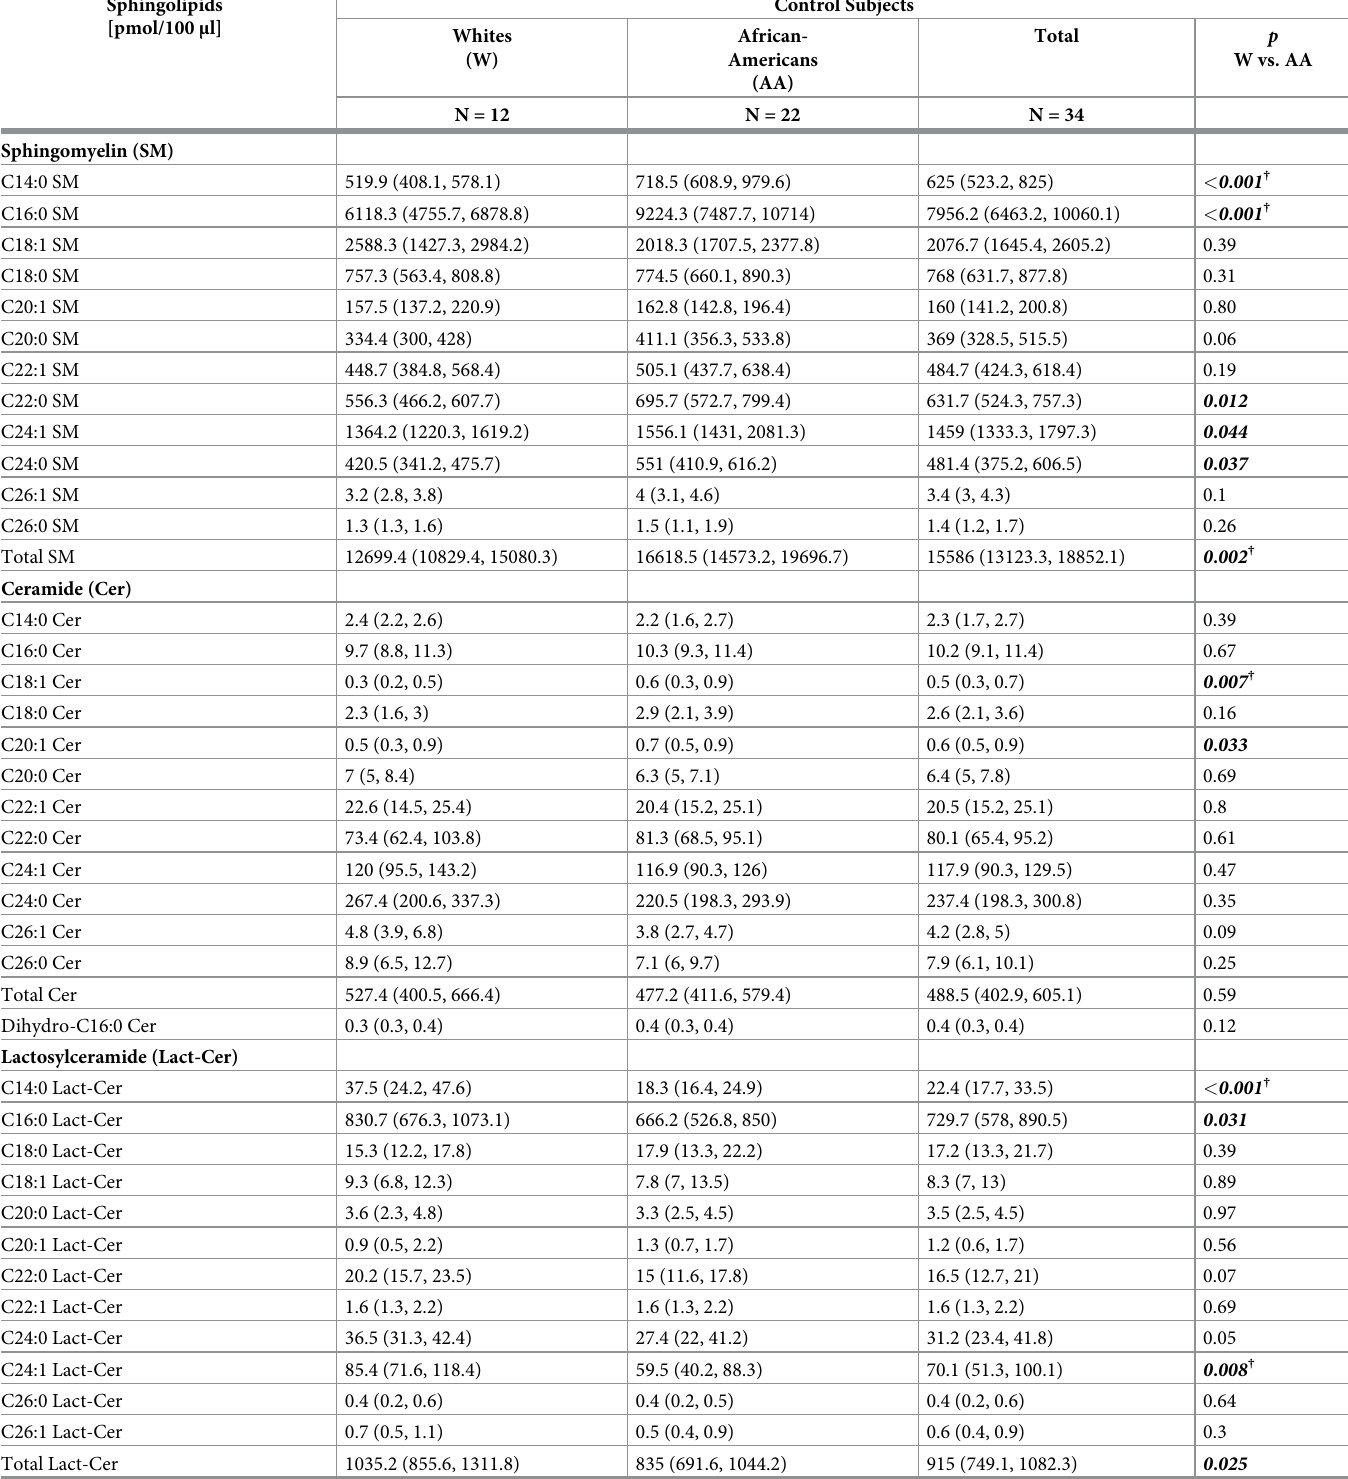
Total p W vs. AA